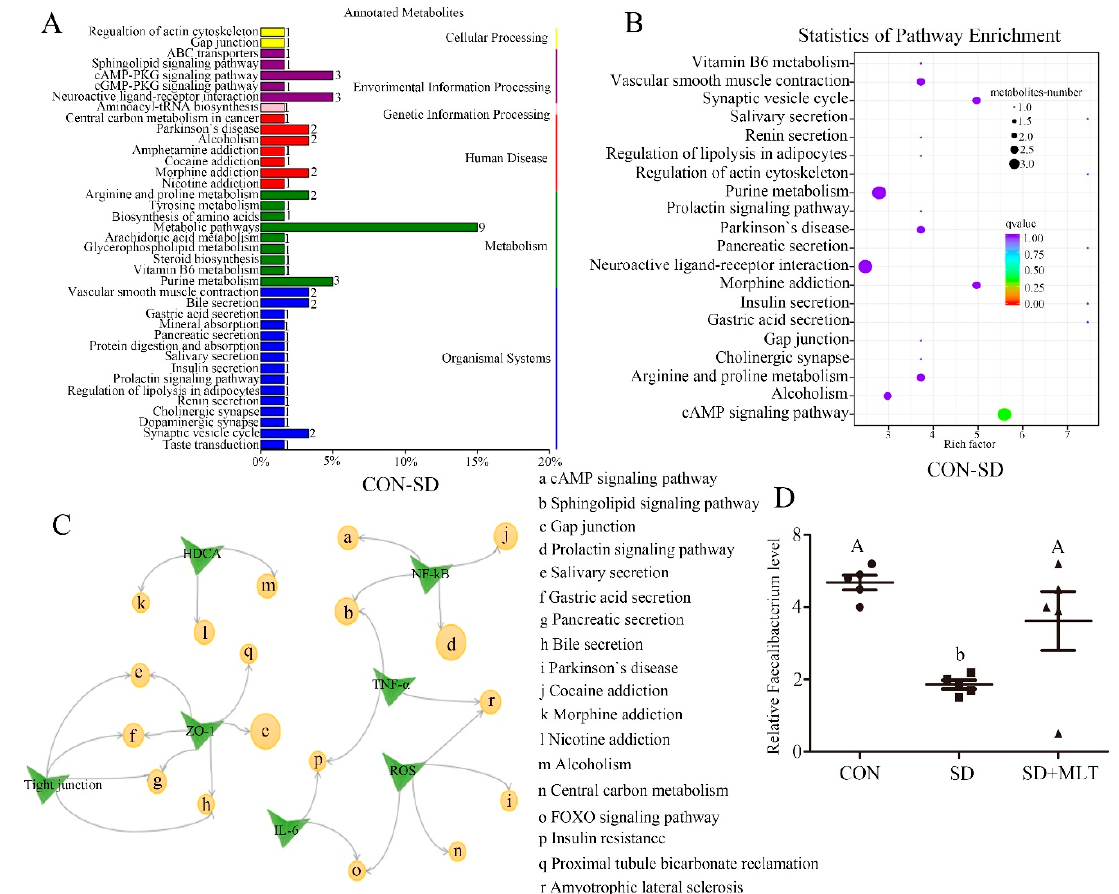
Figure 2. KEGG analysis. KEGG difference analysis ( A ) and KEGG pathway enrichment ( B ), CON group compared to SD group; Links between signal pathways and functions based on KEGG analysis ( C ) ( n = 8). Relative Faecalibacterium level ( D ) was measured using a metabolomics test in the CON, SD, and SD + MLT groups. Values are presented as the mean ± SE. Differences were assessed using ANOVA and are denoted as follows: different lowercase letters: p < 0.05; different uppercase letters: p < 0.01; same letter: p > 0.05.